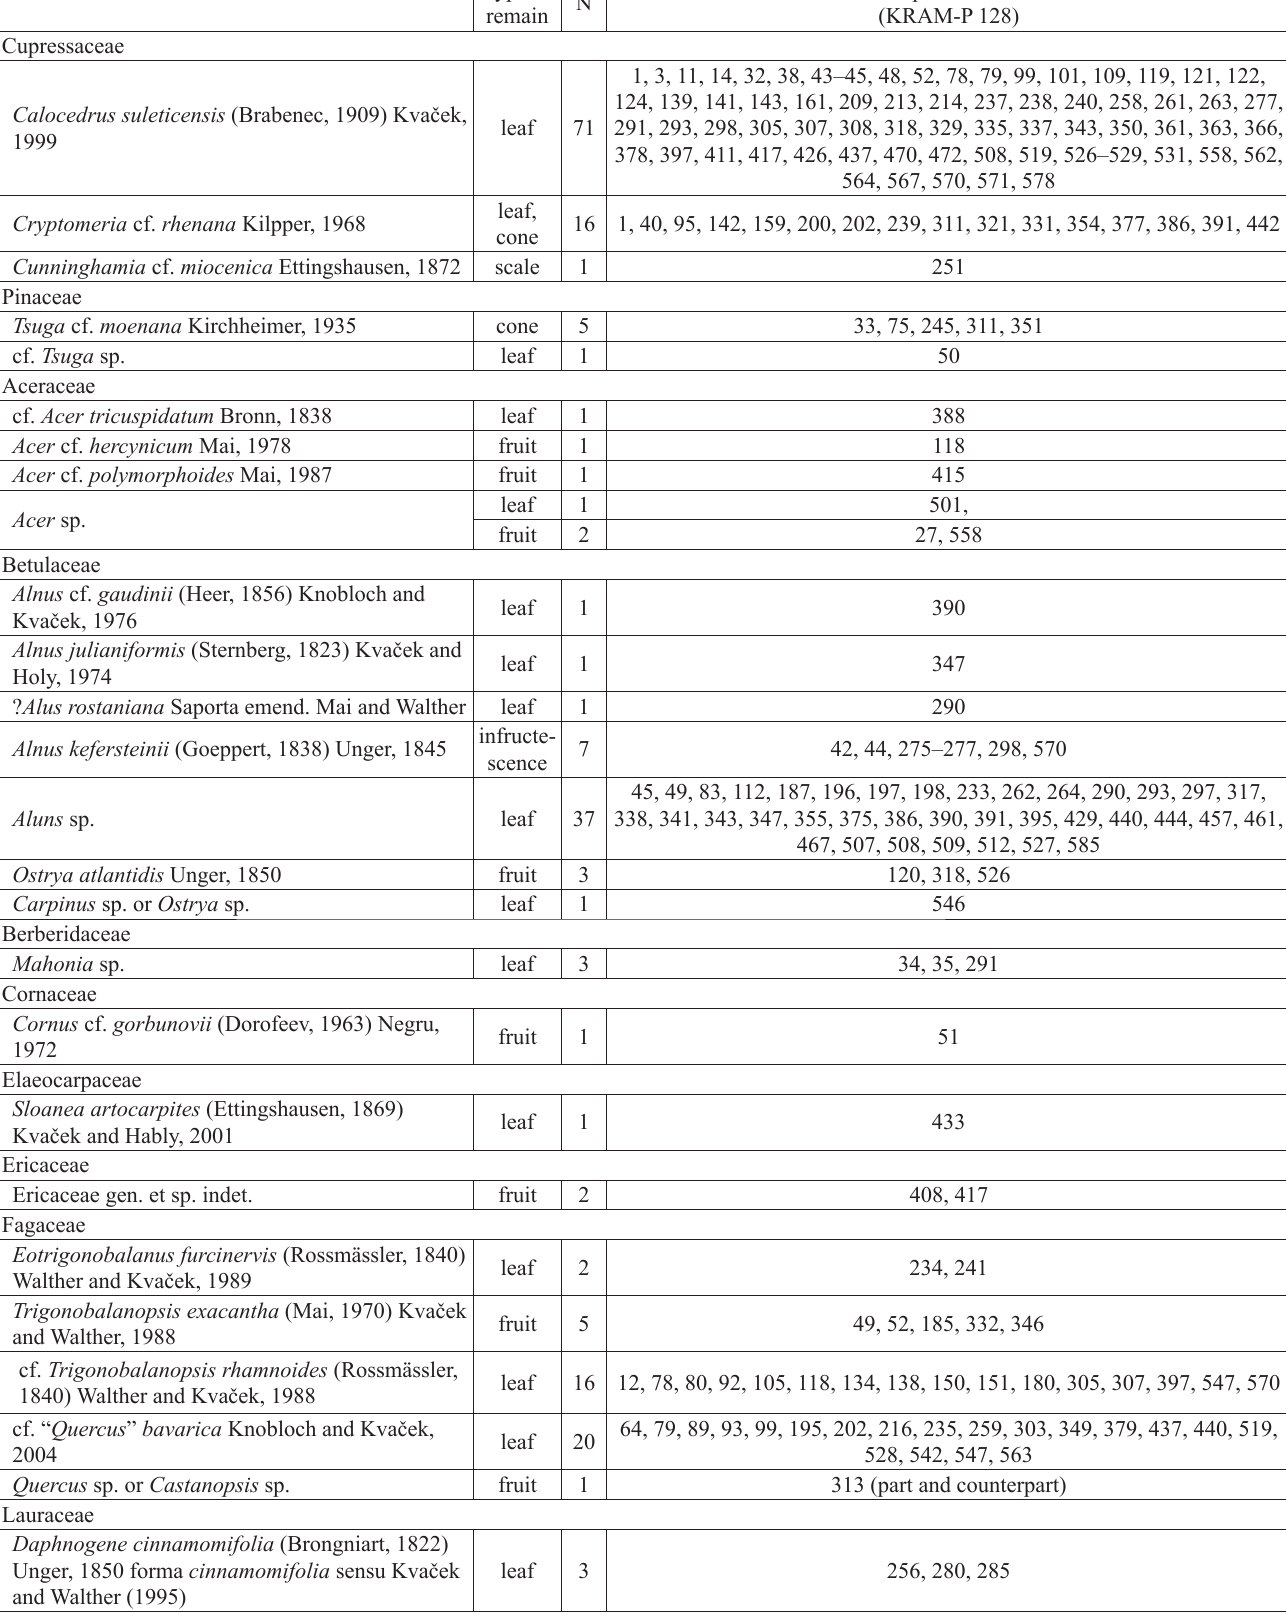
Table 1. Taxa recorded among leaf and fruit/seeds remains from R ę biszów. N, number of